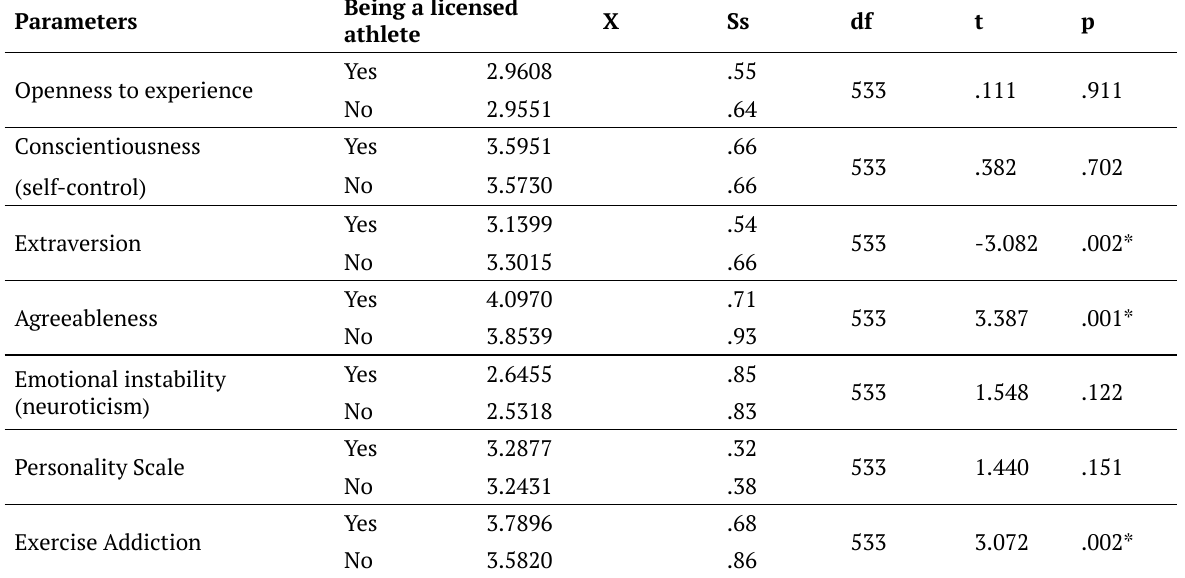
Table 4. T-test results of students’ exercise addiction and personality based on being a licensed athlete